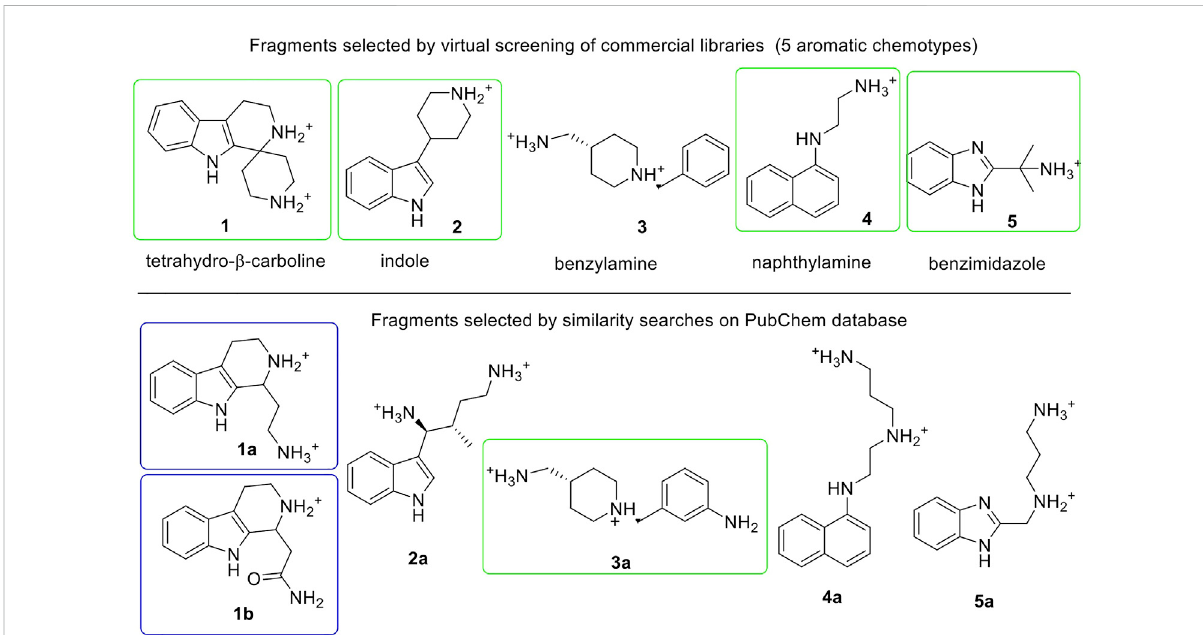
FIGURE 3 Fragmentsselectedbyvirtualscreeningofcommerciallibraries(topsection)andbysimilaritysearchesonPubChemdatabase(bottomsection). Synthetized or purchased compounds for NMR experiments are shown in blue and green boxes, respectively. Only the enantiomer S - 1a was found by similarity search. Fragments are displayed in their most favorable protonation state.